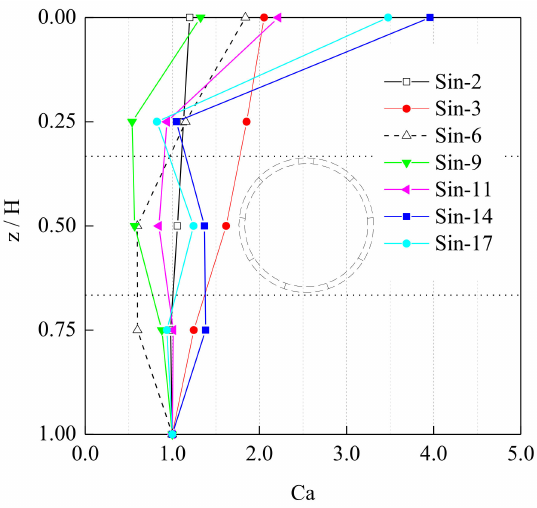
Figure 14. Acceleration amplification coefficients along depths in FF